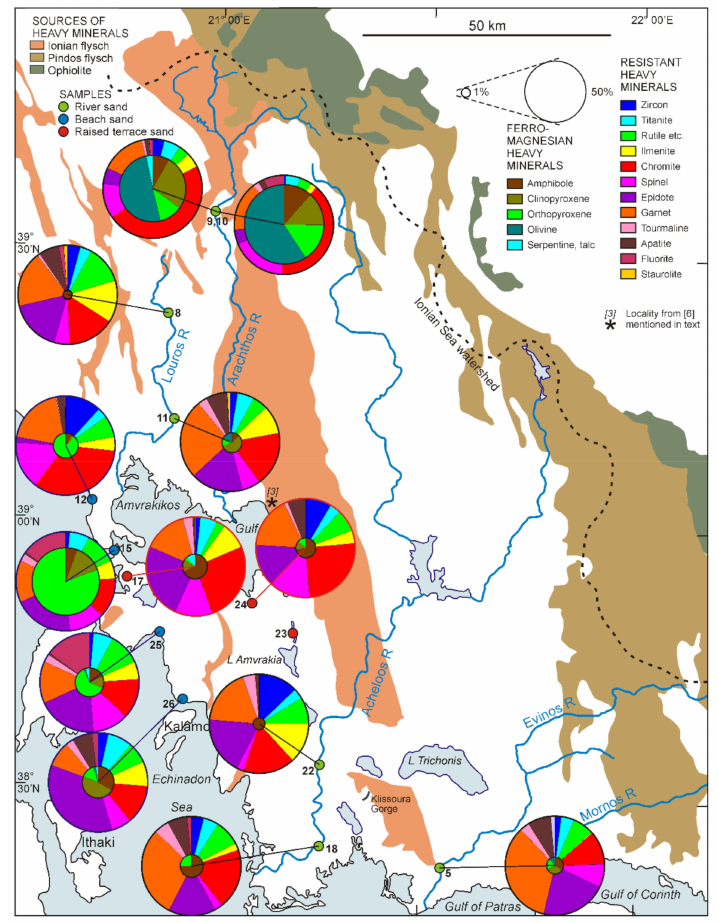
Figure 4. Map showing potential source areas for heavy minerals and pie plots of modal abundance of resistant heavy-minerals (outer ring) and of heavy ferromagnesian minerals (inner ring, size proportional to percentage abundance). Geological units from